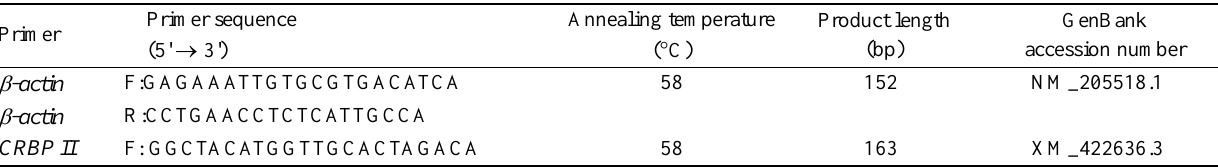
Table 1. Primers used for real-time PCR